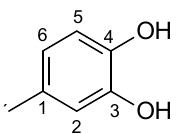
Figure A1. 4-methylcatechol ( 1b ). 1 H NMR (399.87 MHz, DMSO- d 6 , 30 °C): 2.108 (3H, dd, J = 0.7, 0.5